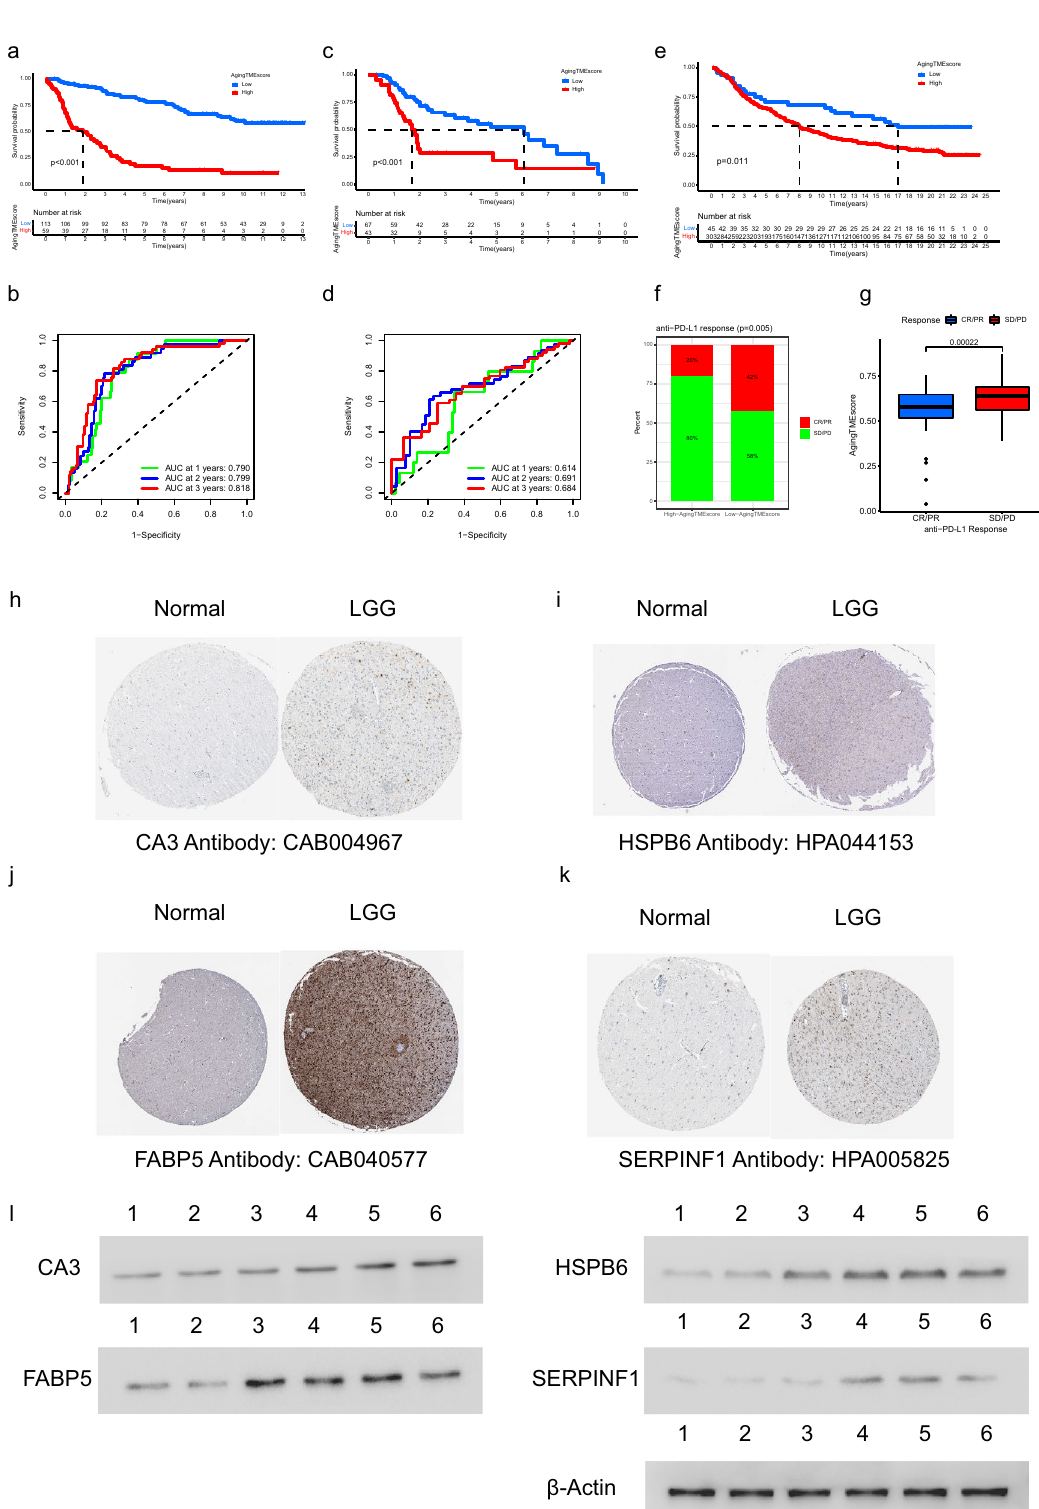
Figure 8. Validation of ATMERS. ( a , b ) Kaplan–Meier survival analysis ( a ) and time-dependent ROC curves ( b ) of aging TME score in the validation cohort from CGGA database (DataSet ID: mRNAseq_325). ( c , d ) Similar results obtained in the merged validation cohort from GEO database (GSE4271, GSE4412, GSE43378 and GSE84010). ( e ) Kaplan–Meier survival analysis between low and high aging TME score groups in IMvigor210 cohort. ( f ) Proportion of anti-PD-L1 therapeutic response in low and high aging TME score groups in IMvigor210 cohort. ( g ) Comparison of ageing TME scores between patients with different anti-PD-L1 therapeutic response in IMvigor210 cohort. ( h – k ) Identification of unfavorable ATMERS in immunohistochemistry staining. ( l ) Determination of unfavorable ATMERS using western blot analysis in which lane 1 represented normal brain tissues, lane 2, 3 represented LGG tissues in grade II, lane 4, 5 and 6 represented LGG tissues in grade III. ATMERS, aging tumor microenvironment related signature; ROC, receiver operating characteristic; AUC, area under curves; TME, tumor microenvironment; LGG, low-grade glioma, CR/PR: complete response/partial response; PD/SD: progressed/stable